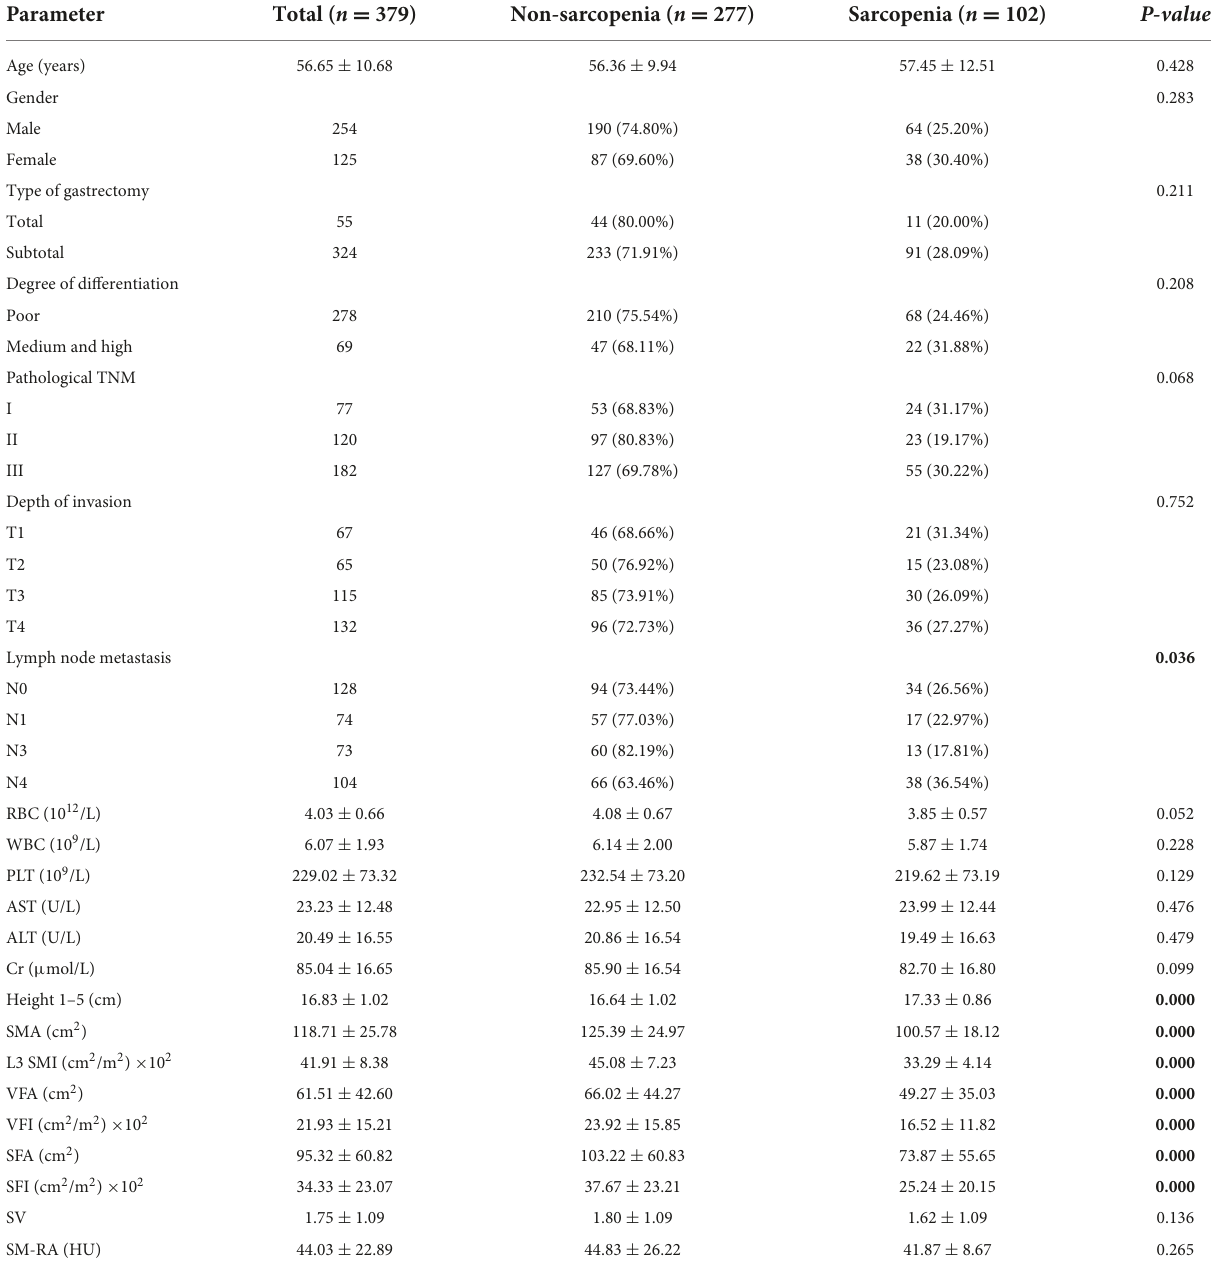
TABLE 1 Baseline clinical characteristics and comparisons between patients with CT-determined sarcopenia and